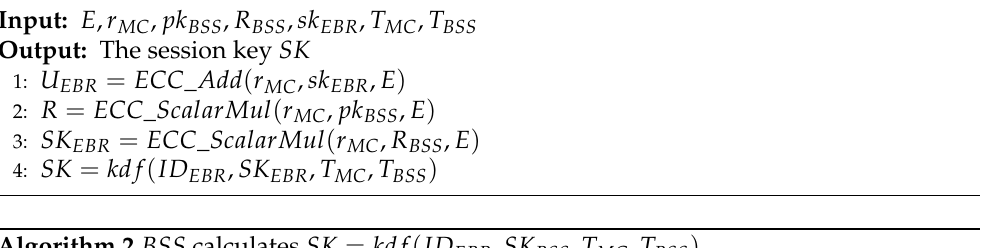
Algorithm 1 EBR calculates SK = kd f ( ID EBR , SK EBR , T MC , T BSS )